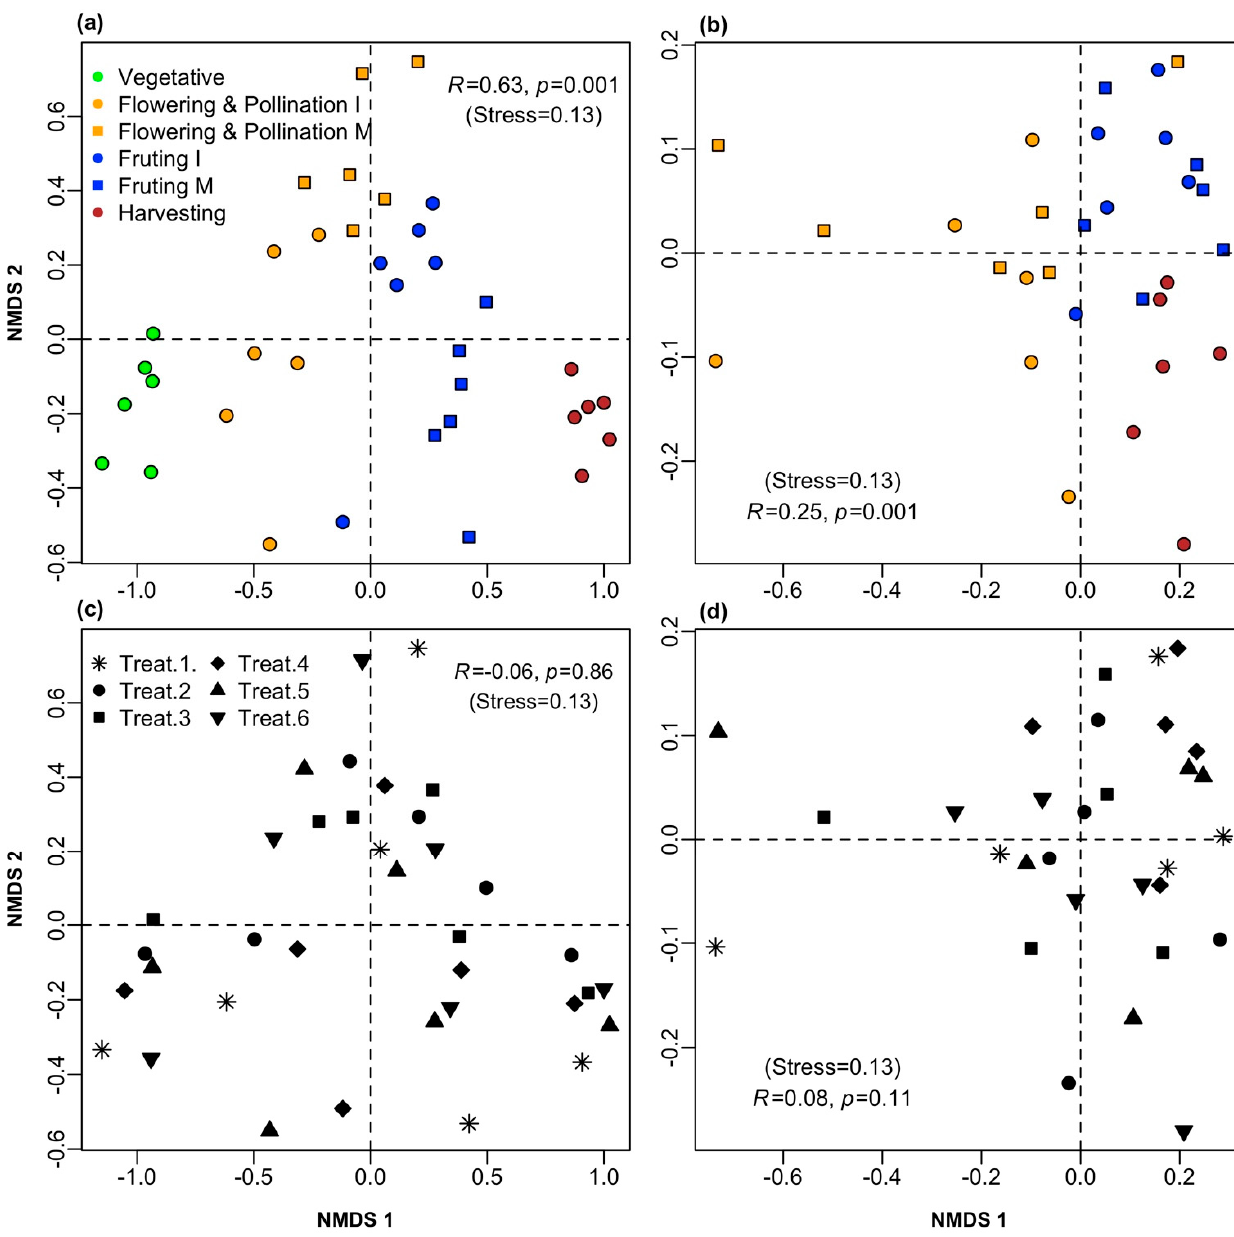
Figure 3. Nonmetric multidimensional scaling of the community structure of bacteria ( a , c ) and fungi ( b , d ).